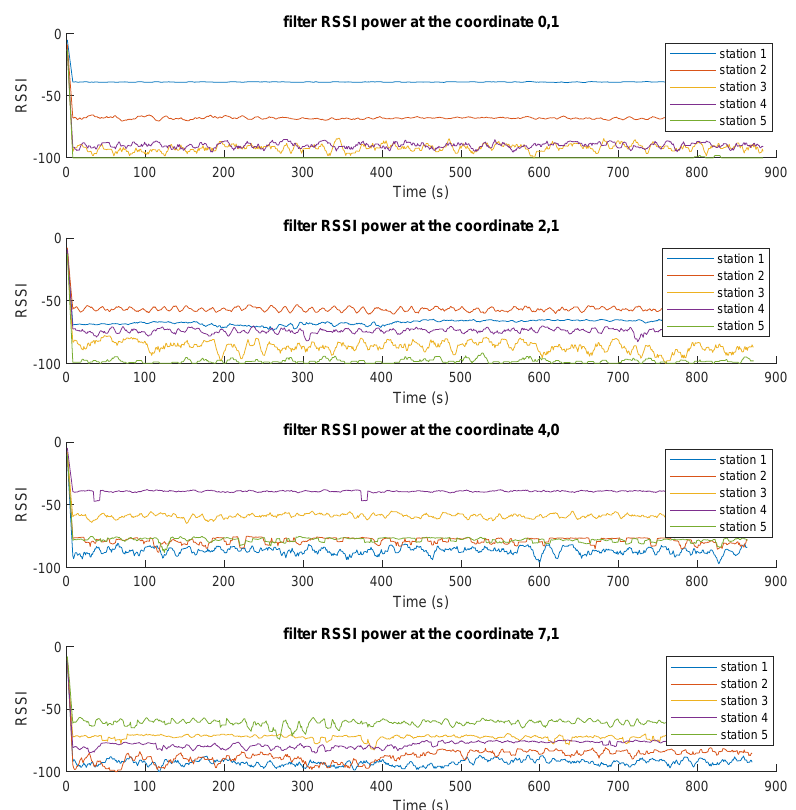
Figure 18. RSSI values after applying the smoothing filter (moving average) for four different locations ( ( 0,1 ) , ( 2,1 ) , ( 4,0 ) , and ( 7,1 )